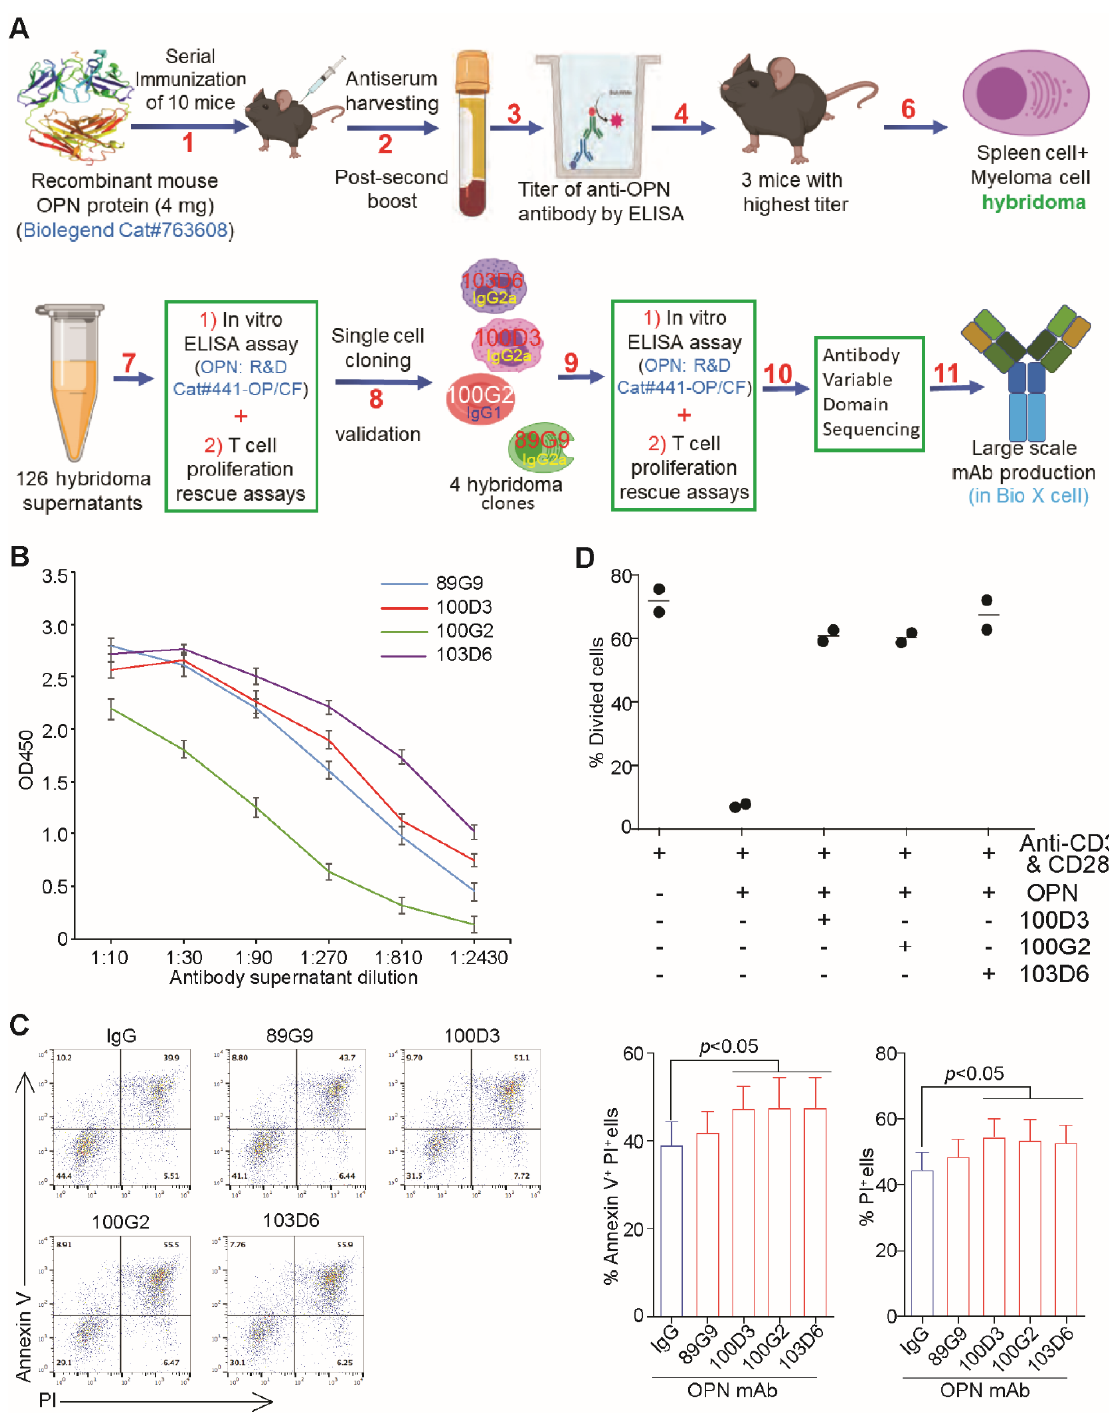
Figure 6. OPN neutralization mAbs increases CTL tumor-lysing efficacy. ( A ) Scheme of OPN neutralization monoclonal antibody production as described in Materials and Methods. ( B ) The four OPN mAb clones were tested for binding affinity to OPN protein by ELISA. ( C ) CT26 cells were seeded in 96-well U bottom plates for 24 h. IgG and the indicated OPN mAbs and CTLs were added to the tumor cell culture for 24 h. Cell mixtures were collected, stained with CD8, Annexin V, and PI, and analyzed by flow cytometry. Representative dot plots are shown at the left, and tumor cell death was quantified and presented at the right. ( D ) CSFE-labelled CD3 + T cells were cultured in 96-well plates coated with anti-CD3, anti-CD28, and OPN as indicated. Cells were analyzed for CSFE intensity 3 days later by flow cytometry. Shown are quantification of % divided cells as determined by CFSE intensity.